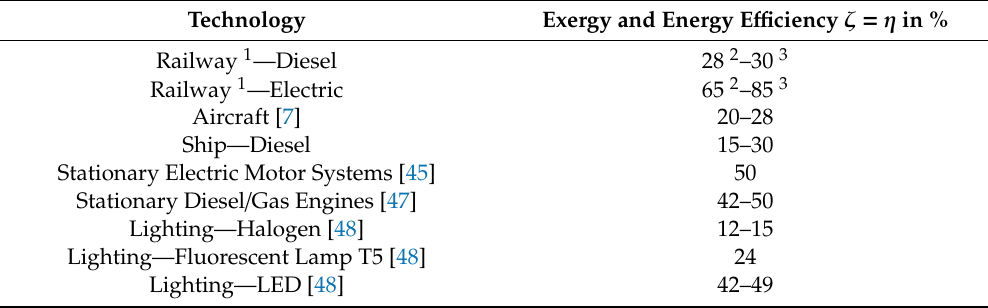
Table 3. Exergy and energy e ffi ciencies of other final energy